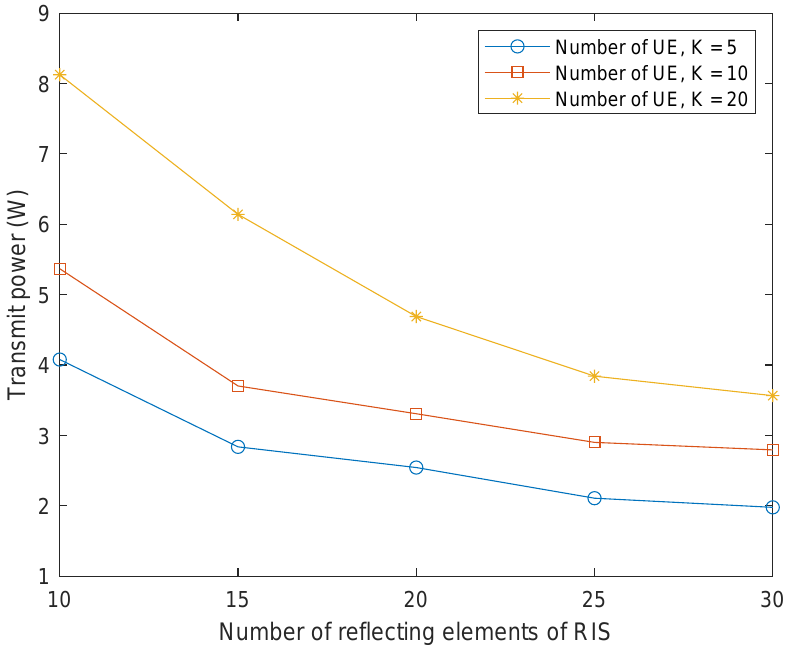
Figure 5. Transmitting power consumption versus the number of RIS reflecting elements.